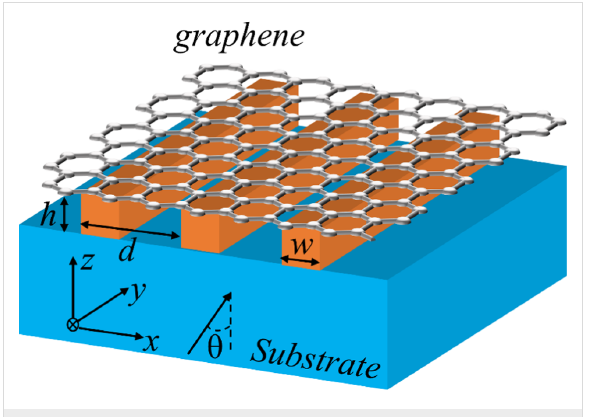
Figure 1: Schematic of the graphene absorber consisting of a graphene monolayer and a substrate separated by a dielectric grating.